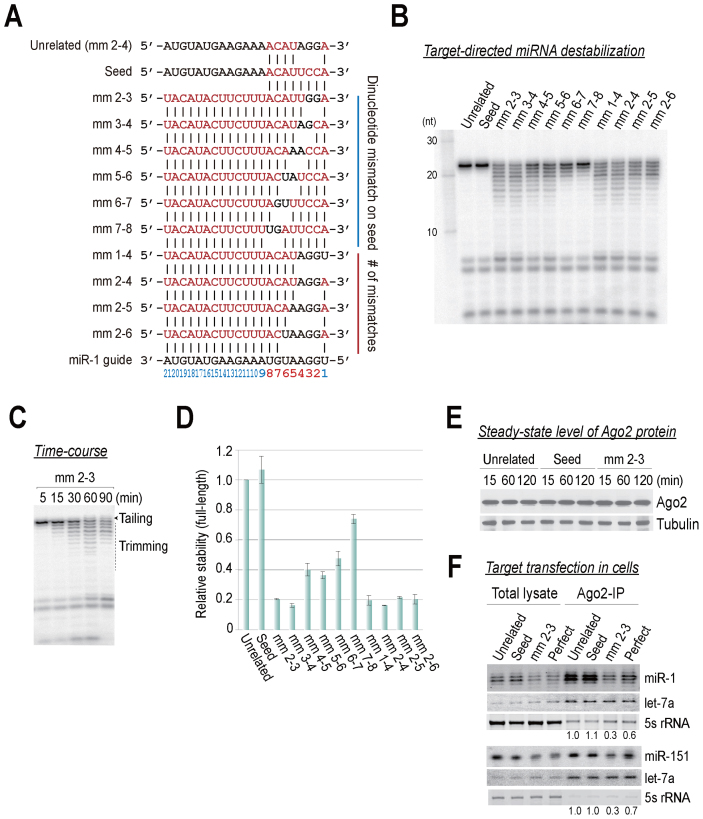
miRNAs are destabilized by seedless, non-canonical targets. (A) Schematic of paired miRNAs and complement target RNAs. (B) The effects of dinucleotide mismatches in the seed region on miRNA stability. (C) Time-course analysis of (B); the mm 2–3 target serves as a representative example. (D) Quantitation of (B). The means ± SDs for two independent replicate experiments are shown. (E) Western blot analysis using an anti-FLAG antibody confirmed the expression of the tagged Ago2 protein. Anti-tubulin served as an internal control. (F) HEK293T cells were transfected with 10 nM miRNA duplex, 100 nM target RNA and FLAG-Ago2 expression plasmid. Cell lysates were subjected to FLAG-IP, followed by northern blotting using the miR-1 or miR-151 probe. The numbers below the blot are the relative expression levels, normalized using let7a as a loading control. Ethidium bromide-stained 5s rRNA served as another loading control.